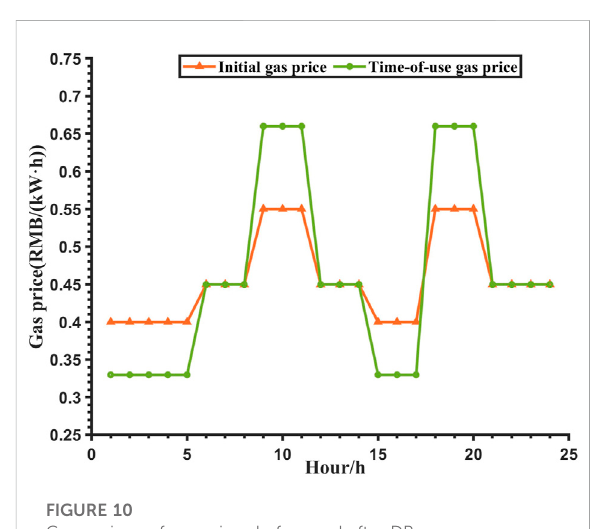
FIGURE 10 Comparison of gas prices before and after